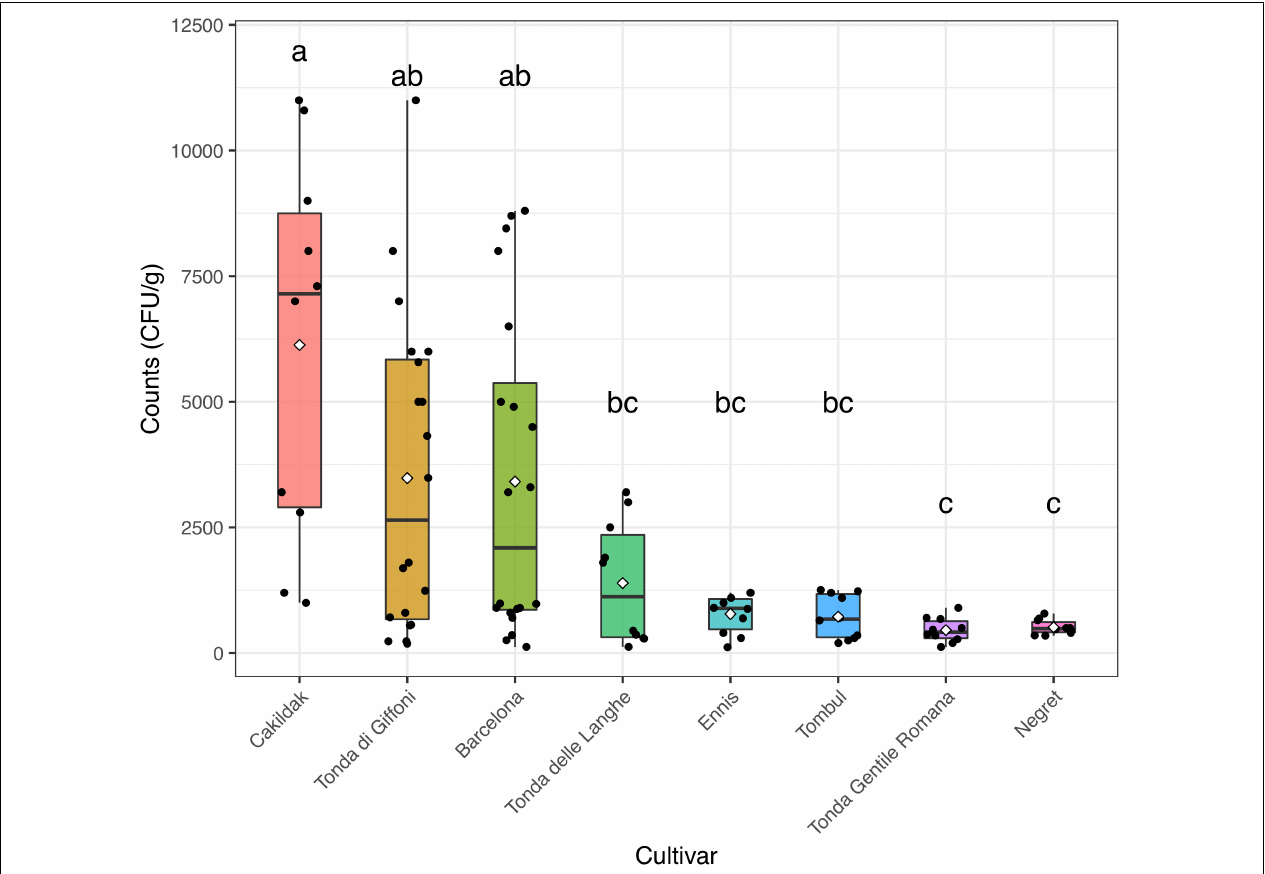
FIGURE 2 | Box and jitter plots representing fungi occurrence (CFU/g) in hazelnuts samples from different cultivars. In a boxplot, the bottom and top of the boxes represent the quartiles (25th and 75th percentile), with the line and rhombus inside the box representing the median and mean, respectively. Different letters show significant differences determined by the ANOVA test ( P < 0.05) followed by the Tukey HDS post-hoc